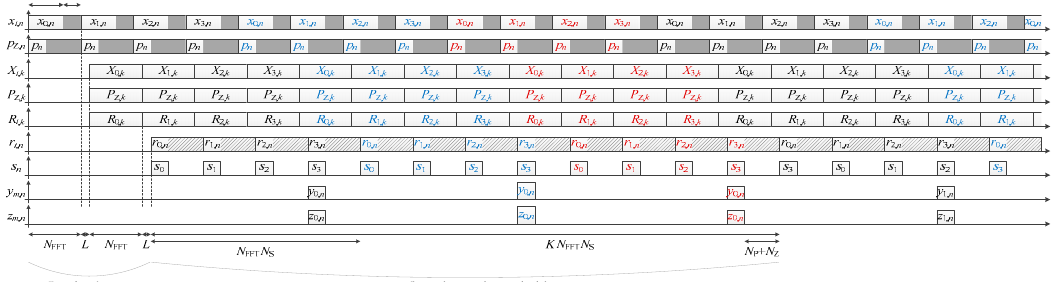
Figure 6. Implementation of a pilot channel acquisition, without non-coherent accumulation, in a serial way (timing diagram available in Figure 7). Sensors 2018 , 18 , x FOR PEER REVIEW